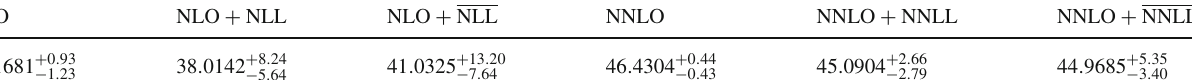
uncertainties around the central scale value is calculated by varying μ F keeping μ . The 2